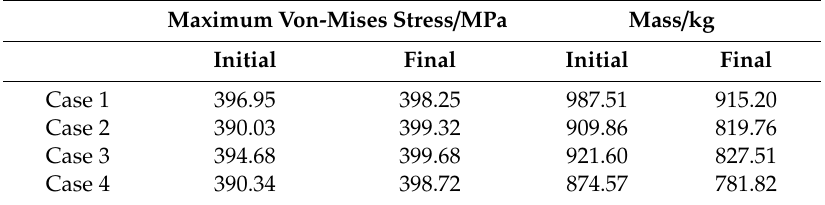
Figure 14. Comparison of the maximum von-Mises stress and mass between the initial and final design. ( a ) The von-Mises stress ( b ) Mass. Table 1. Results of the initial and the final maximum von-Mises stress and mass of the four cases.